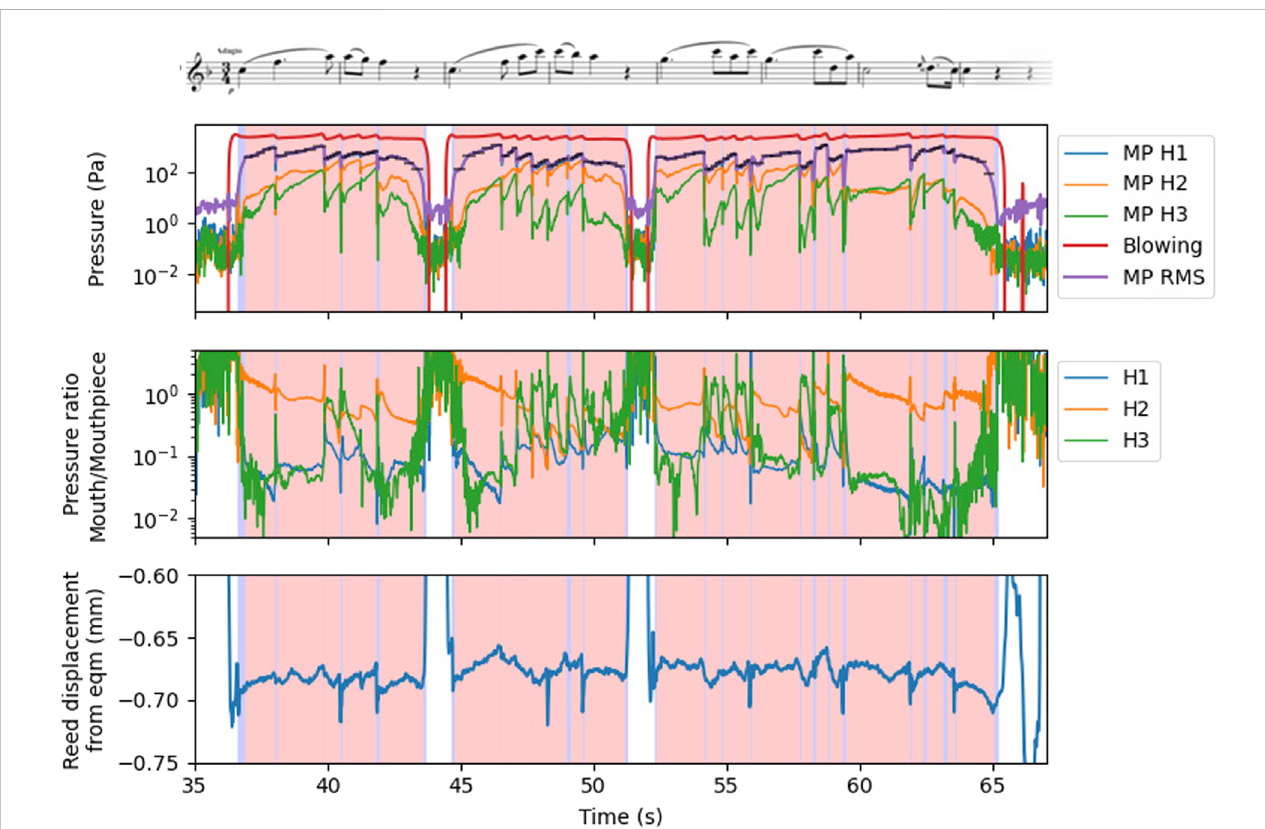
Figure 5: fi rst, all raw signals are synchronized from different devices; second, several meaningful time series are extracted from raw signals and from videos (to obtain the lip position at which the player bites the reed and motion of the clarinet); third, a semi- automated segmentation is run on one of the audio signals to label note boundaries; fourth, several descriptive statistics from the time series are calculated for each note using labelled note boundaries, and fi fth, transients are detected for each note for calculating transient